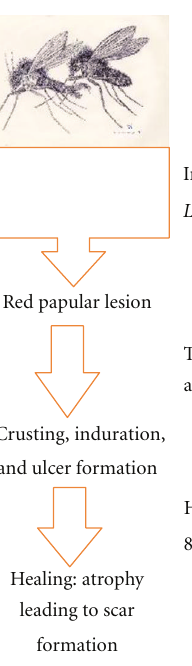
Figure 1: Typical sequence of events leading to the formation of the typical oriental or “yearly sore” called “kal dana.” Description adopted from excellent review by Arfan u Bari et al., 2009. Picture of Sandflies obtain through the courtesy of Bruce Alexander, Research Fellow in Molecular and Biochemical Parasitology Group, Liverpool School of Tropical